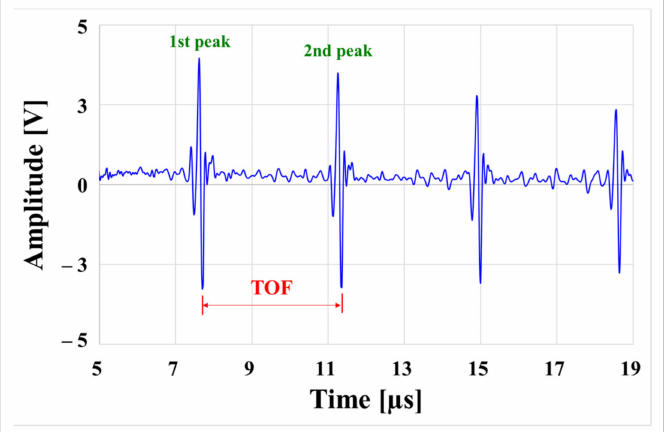
Figure 9. Ultrasonic shear wave measurement signal.